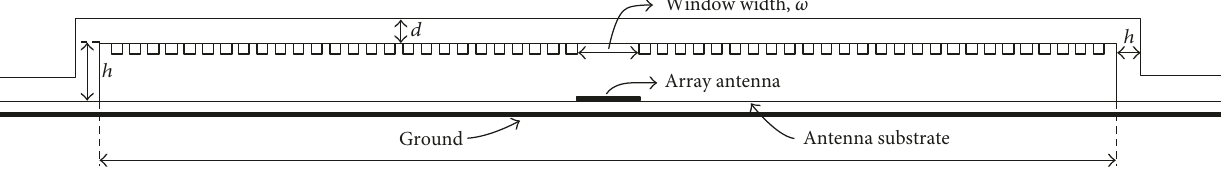
Figure 14: Defected corrugated radome (side view).